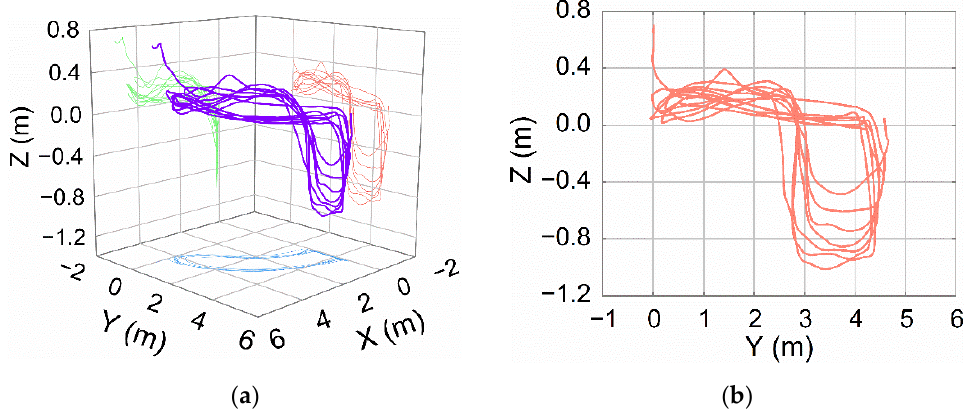
Figure 7. Bucket-tip trajectory in pose space according to our proposed method. Purple, blue, green and red curves are optimal trajectory, XY projection, XZ projection and YZ projection, respectively.